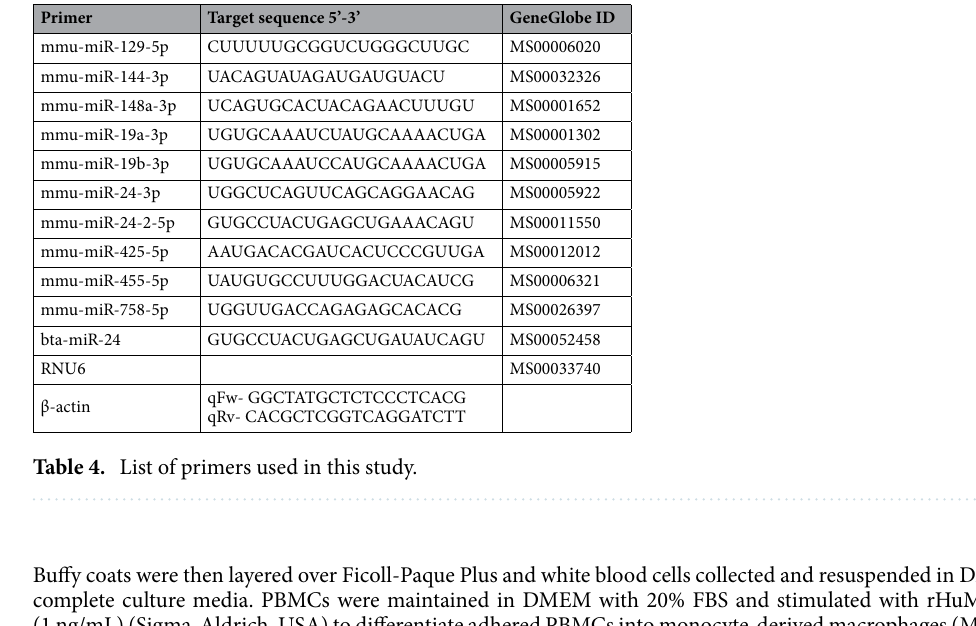
DNase treatment.